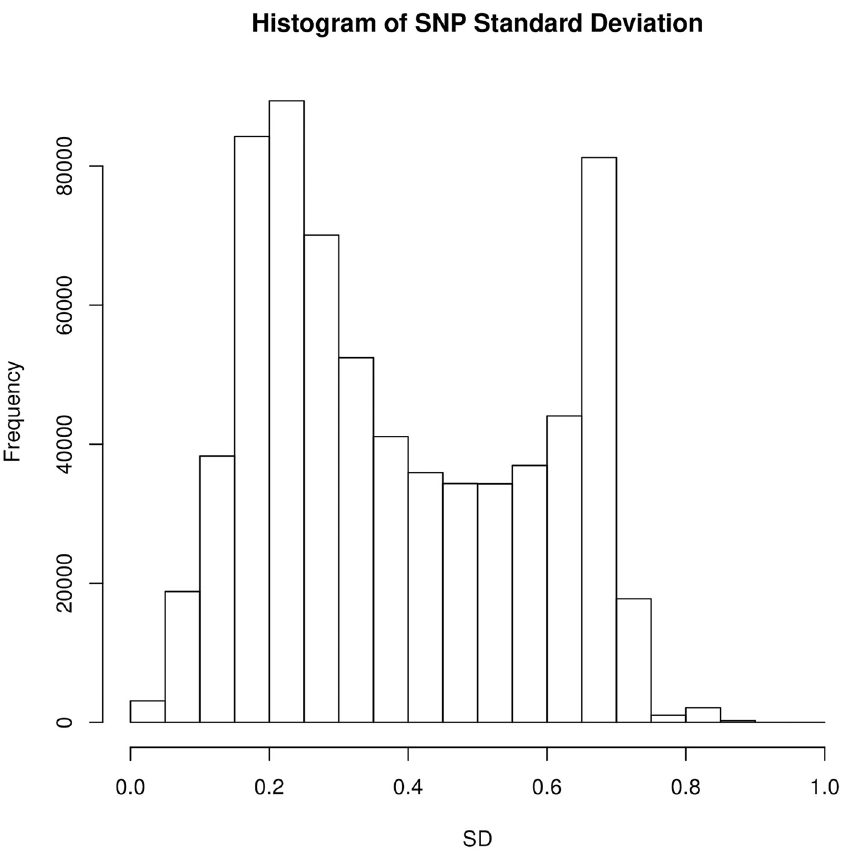
Fig 7. Histogram of the standard deviations of the SNPs. They are computed after mean imputation of the missing values because they would be the exact standardization factors to be used if the lasso were applied with variable standardization on the mean-imputed SNP